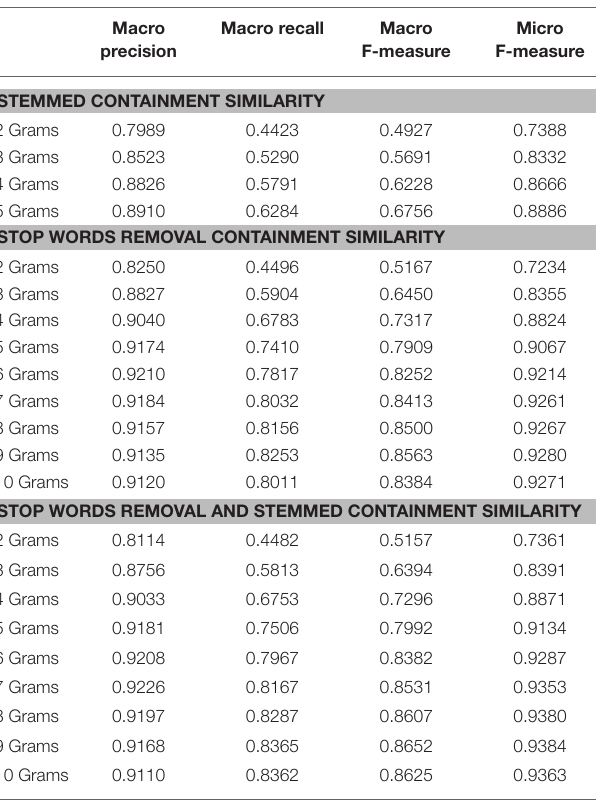
TABLE 4 | Evaluating preprocessing techniques with Reuters-21578 and containment similarity.